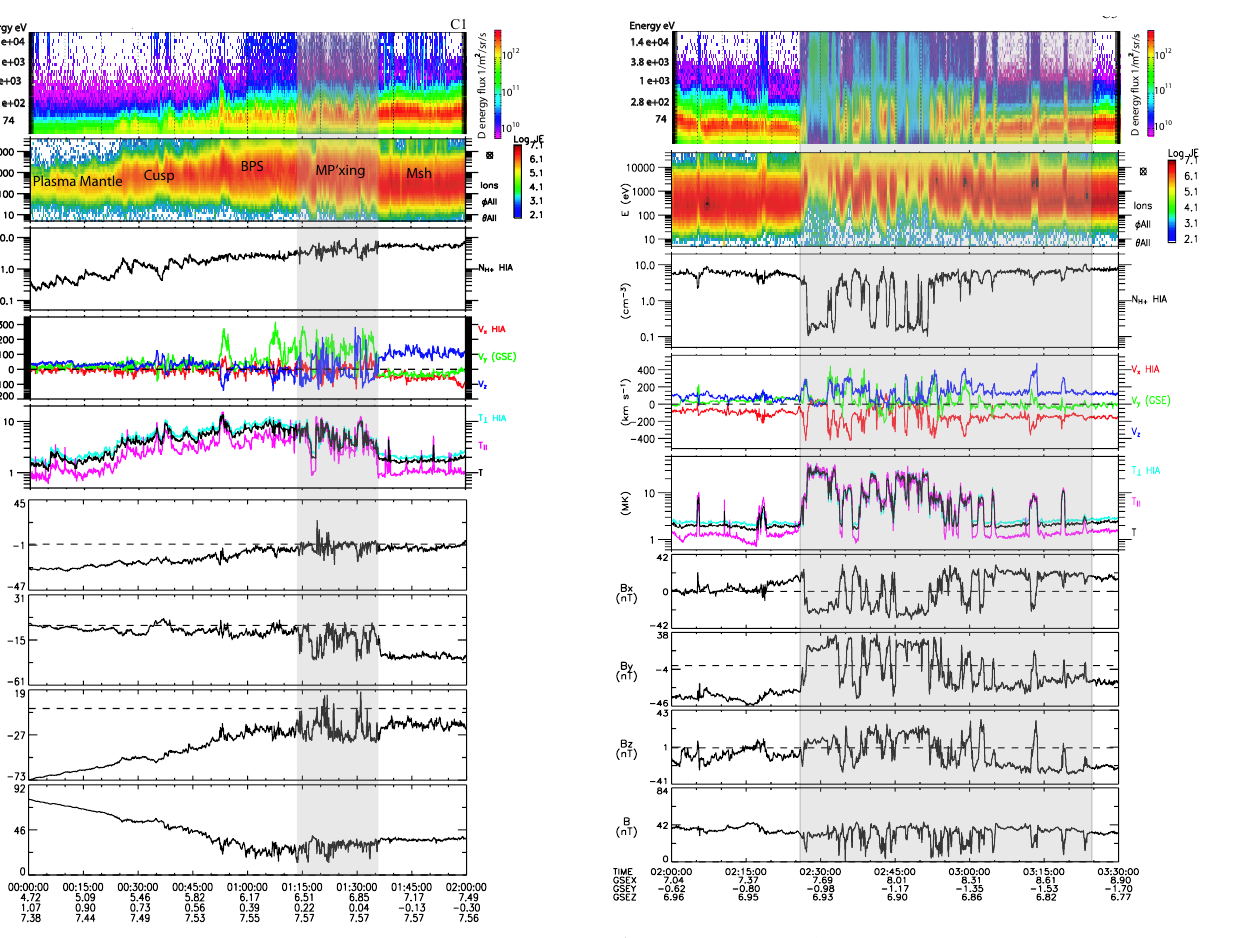
Fig. 4. The overview of the boundary crossings with small mag- netic shear. The top panel is the electron energy-time spectrogram, the next four panels show the ion data from HIA and the bottom four panels are the magnetic field data. From top to bottom is the electron energy-time spectrogram, the ion energy-time spectro- gram, density, the three components of velocity in GSE coordinates with the x component in red, y in green and z in blue), the parallel (red) and the perpendicular (blue) temperature, the x component of the magnetic field in GSE- B x , B y , B z and B, respectively. Notice the different regions traversed by the spacecraft, as shown in the top panel.